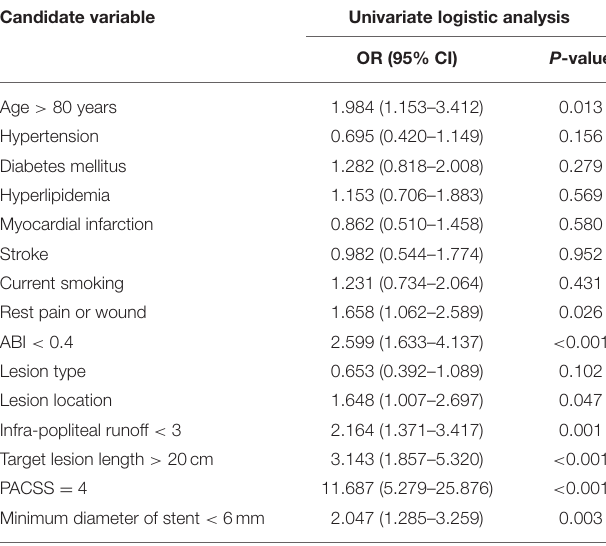
TABLE 2 | Univariate logistic regression screening for candidate variables.